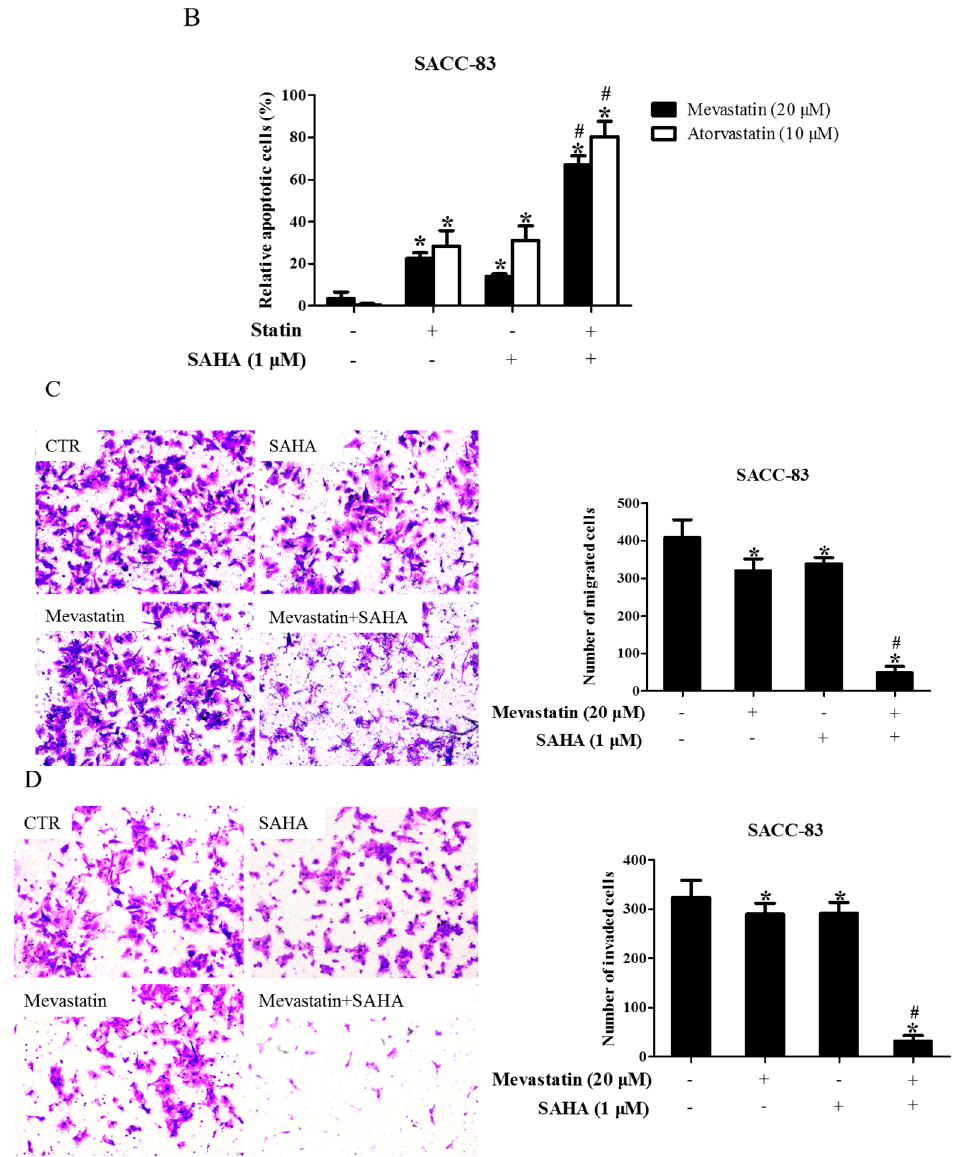
Figure 1. Suberoylanilide Hydroxamic Acid (SAHA) enhanced statin-induced anti-cancer effects. SACC-83 and CAL27 cells were exposed to either statin (mevastatin/atorvastatin), SAHA, or both for 48 h. Cell viability was assessed by Cell Count Kit-8 assay, n = 4 ( A ); The rate of apoptotic SACC-83 cells was quantified, n = 6 ( B ); Microphotographs of cell migration ( C ) or invasion ( D ) of cells after different treatment for 16 h, n = 6 (20×). * P < 0.05 vs. control group; # P < 0.05 vs. SAHA or statin (mevastatin/atorvastatin) group.